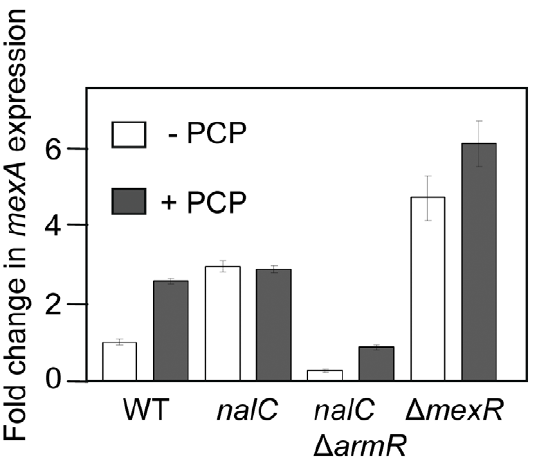
Figure 5. NalC and MexR dependence of PCP induction of mexAB-oprM . Expression of mexA (as a measure of mexAB-oprM ) was assessed in P. aeruginosa strains K767 (wild type; WT), K1454 ( nalC ), K2276 ( nalC D armR ) and K2568 ( D mexR ) exposed or not to PCP (0.75 mM; 1.5 hr) using qRT-PCR. Expression was normalized to rpsL controls and is reported relative (fold change) to untreated P. aeruginosa K767. Results shown are the mean + / 2 standard error of one cDNA sample for each, processed in triplicate, and are represen- tative of 2 independent experiments.